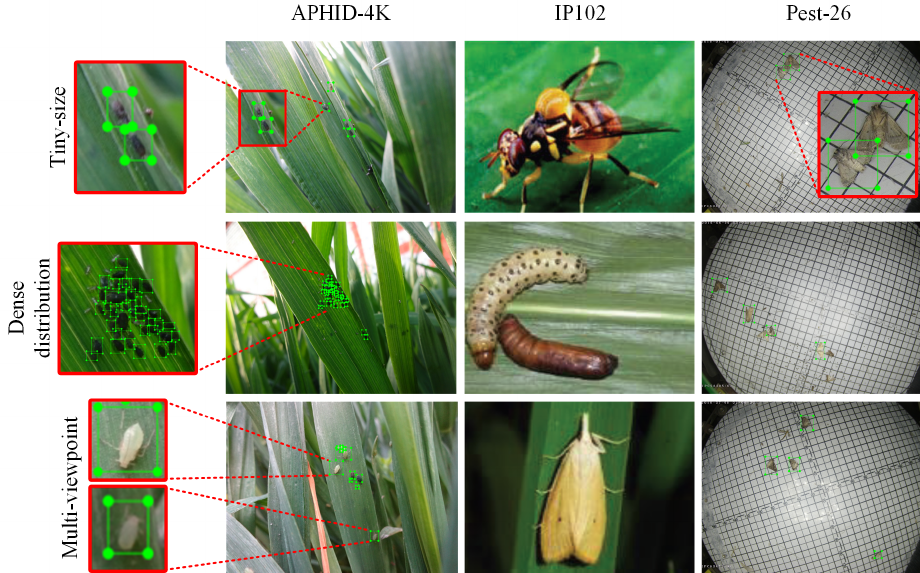
Figure 1. The comparison of the APHID-4K and other pest